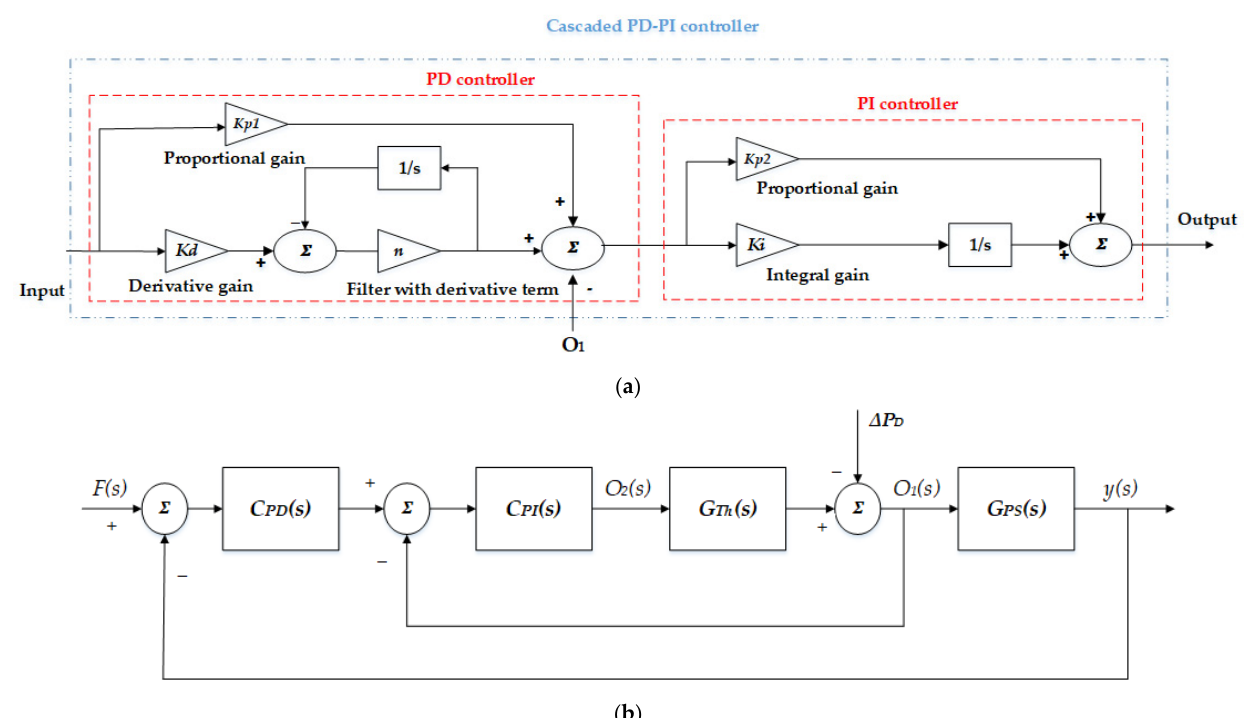
Figure 1. Block diagram for a two-area power system model [25,42].